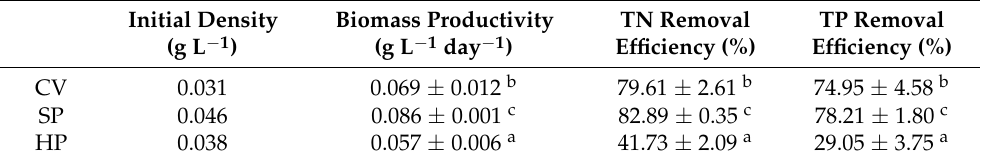
Table 1. Biomass production and TN & TP removal rates for C. vulgaris (CV), S. platensis (SP), and H. pluvialis (HP) during the cultivation period. Values within columns followed by different letters are significantly different ( p < 0.05, Duncan’s test). Standard deviation of the mean was calculated based on n = 3 (CV, SP & HP).